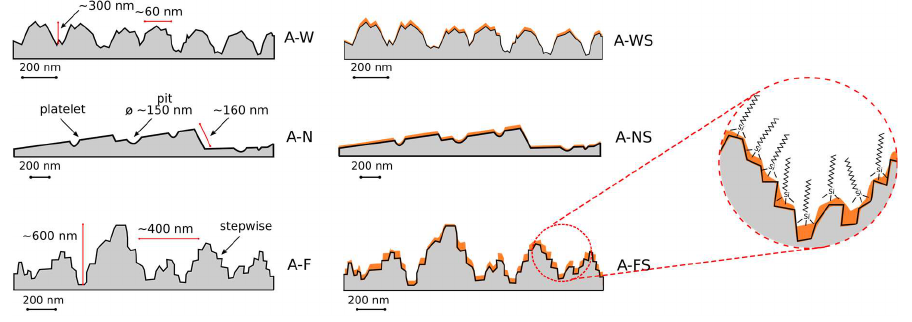
Figure 7. Scheme of structural super-hydrophobic surfaces of coatings.